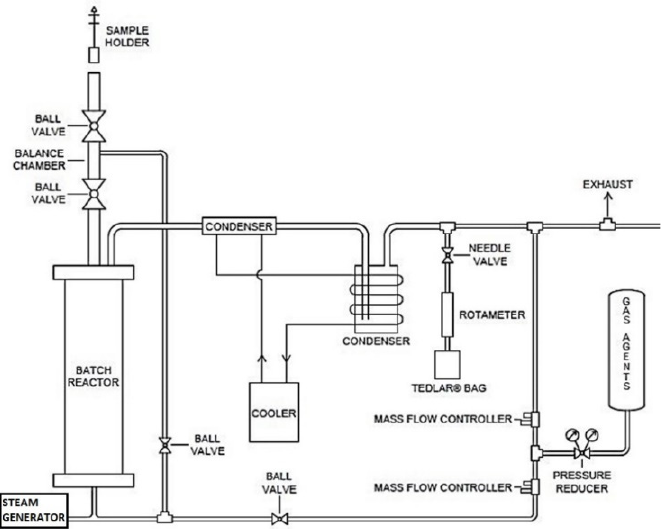
Figure 1. Pyrolysis system (modified from reference [33]).